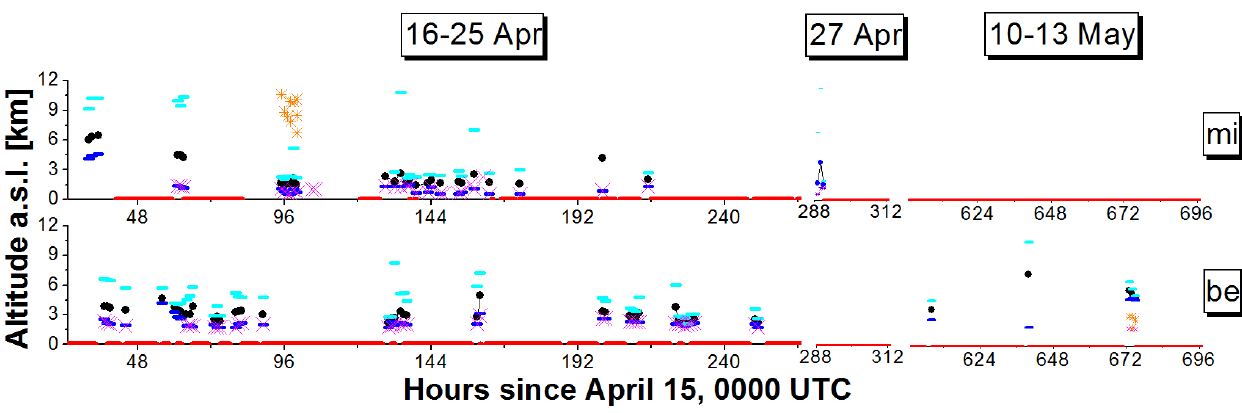
Fig. 9. As Fig. 5 for Eastern Europe cluster: Minsk (mi) and Belsk